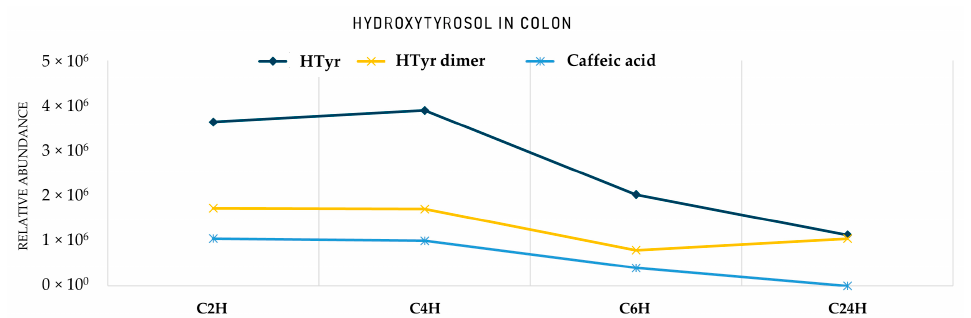
Figure 8. Area of HTyr metabolites in the colon. C2H : Colon T = 2 h; C4H : Colon T = 4 h; C6H : Colon T = 6 h; C24H : Colon T = 24 h. HTyr dimer : Htyr26